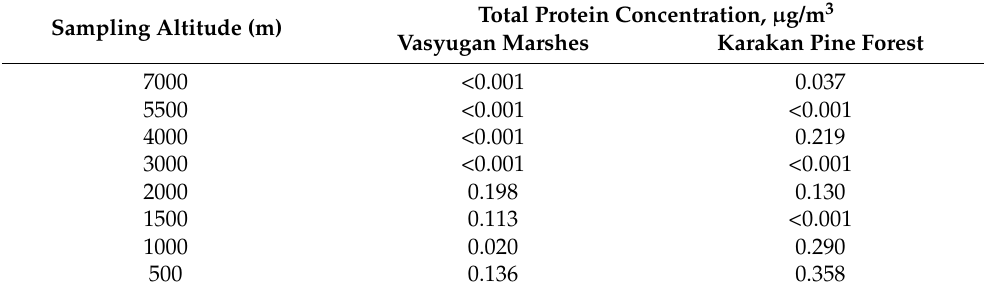
Table 1. The concentration of total protein in the studied samples of atmospheric aerosol.